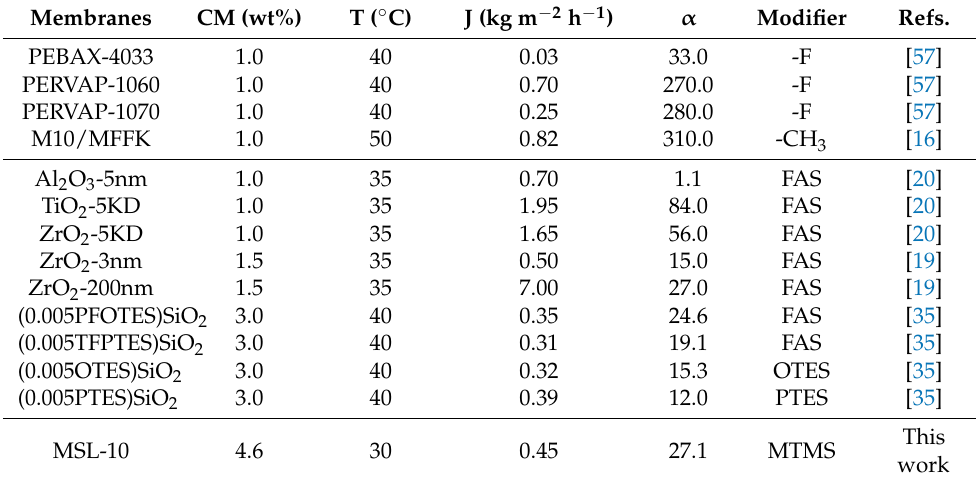
Table 3. MTBE/water separation performance of various membranes. Membranes CM